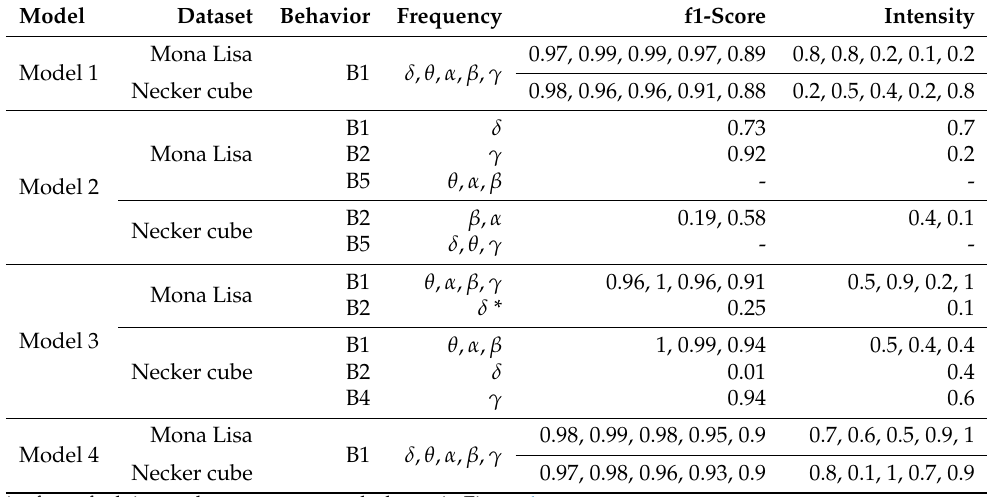
Table 13. The results of using the models with an SGD optimizer for intensity classification.